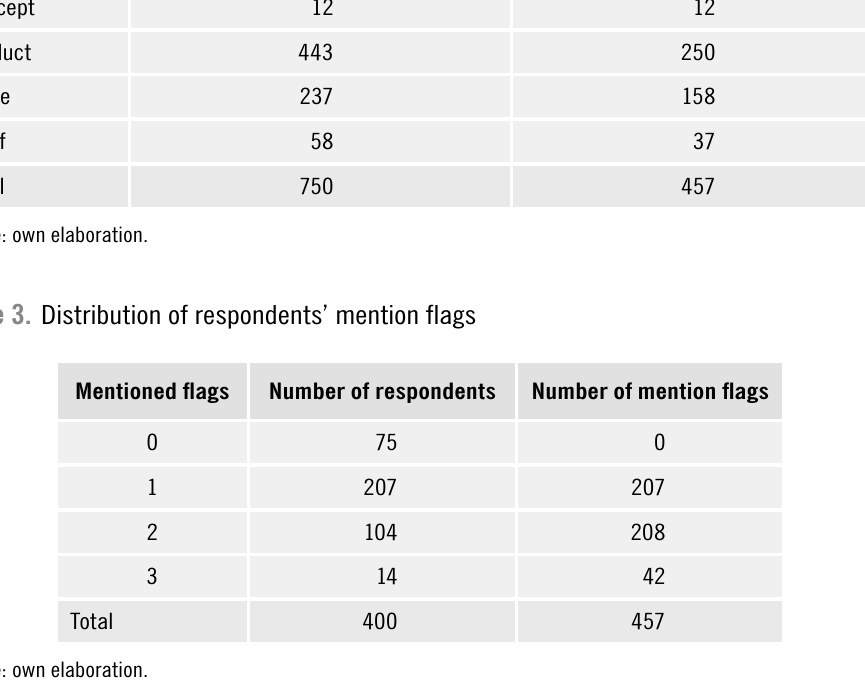
Figure 1. Word cloud of the top 30 frequently occurring words (nouns / adjectives)